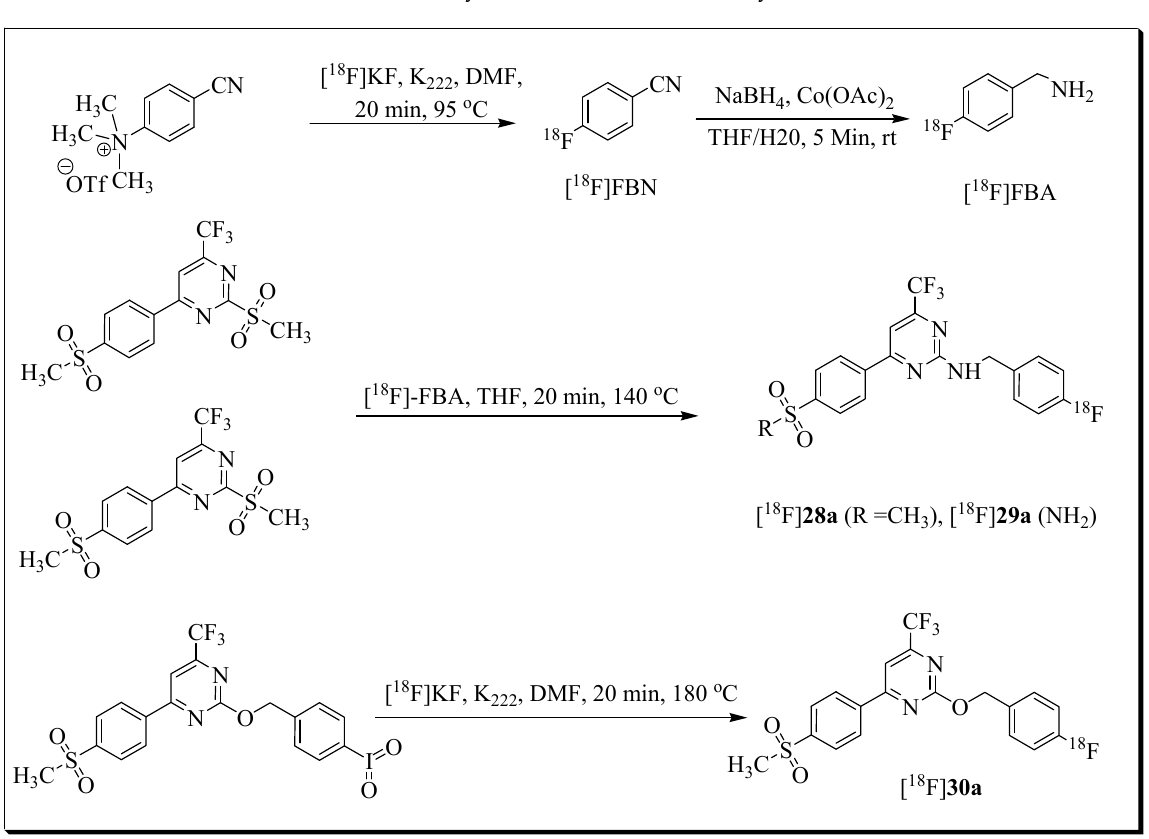
Figure 6. Radiosynthesis of [ 18 F] 28a [ 18 F] 29a , and [ 18 F] 30a . The radiotracers were tested in COX-2-expressing human HCA-7 colorectal cancer cells, and in vitro specificity was examined using COX-2-negative HCT-116 cells, and by blocking studies with COX-2 inhibitors [76,77] blocking studies with COX-2 inhibitors